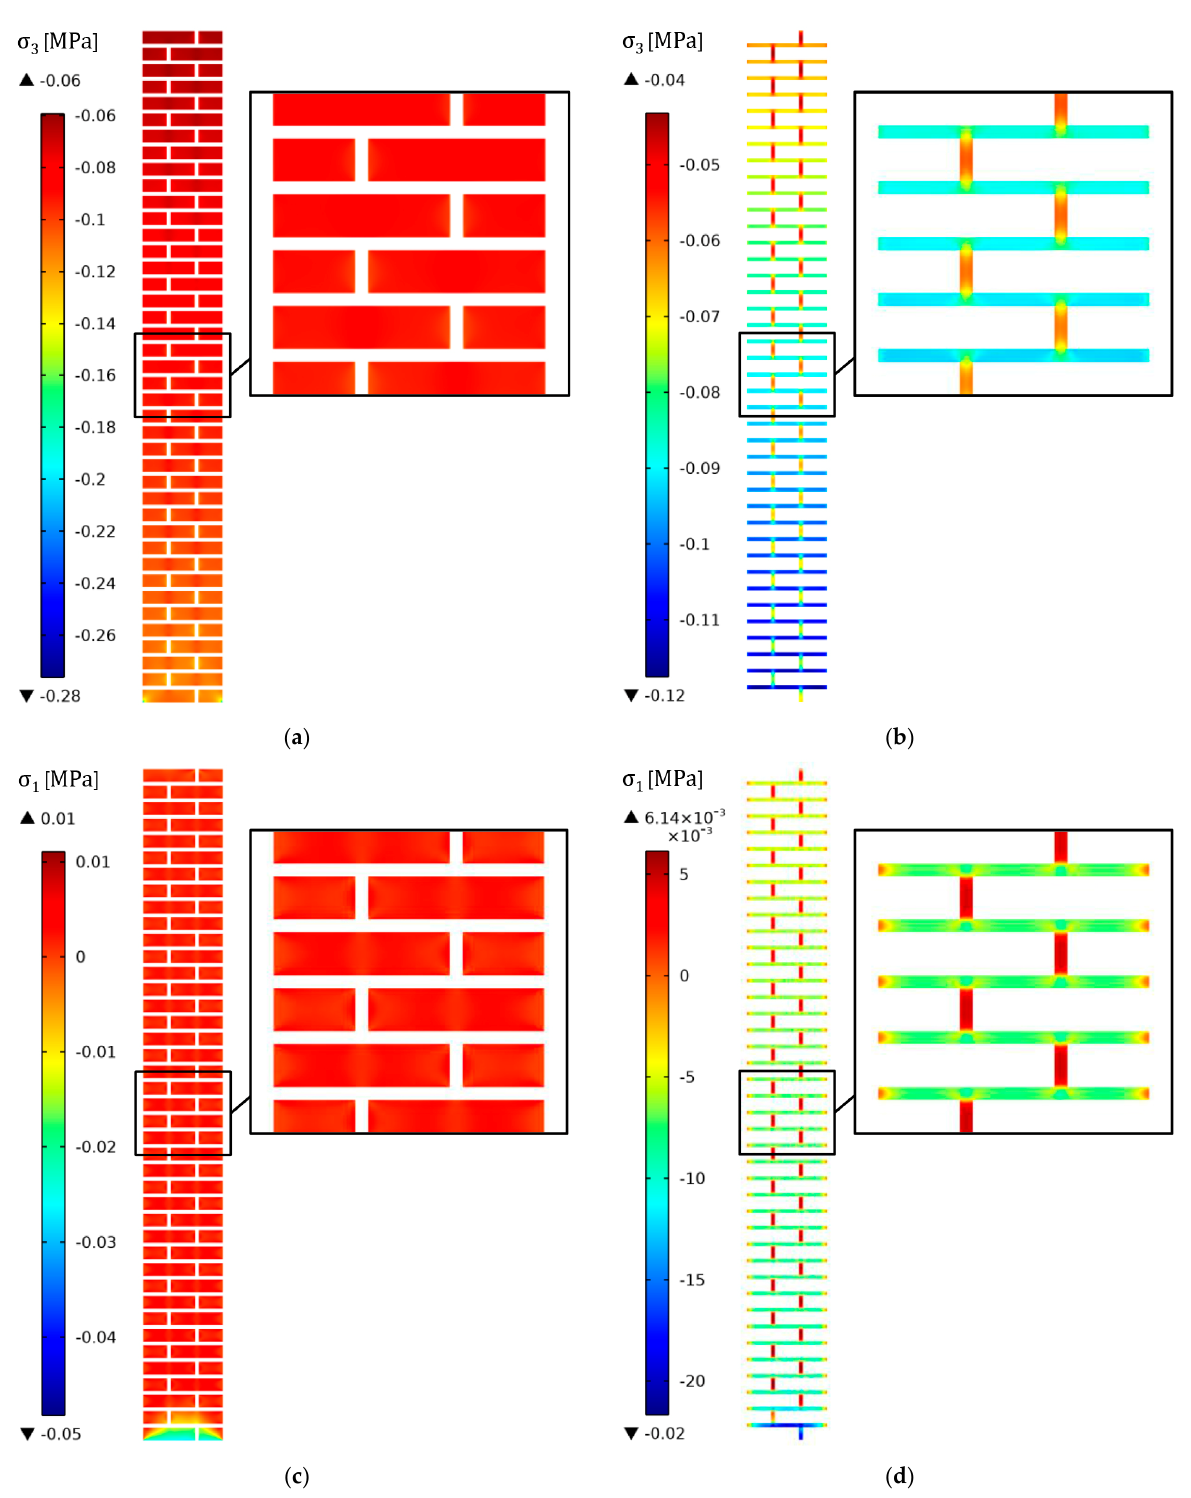
Figure 12. Hygro-thermo-mechanical analysis of the three-wythe brick masonry wall with natural hydraulic lime mortar. Principal stress distribution obtained for the gravitational loads alone: minimum principal stress, σ 3 [MPa], in ( a ) bricks and ( b ) mortar joints; maximum principal stress, σ 1 [MPa], in ( c ) bricks and ( d ) mortar joints.